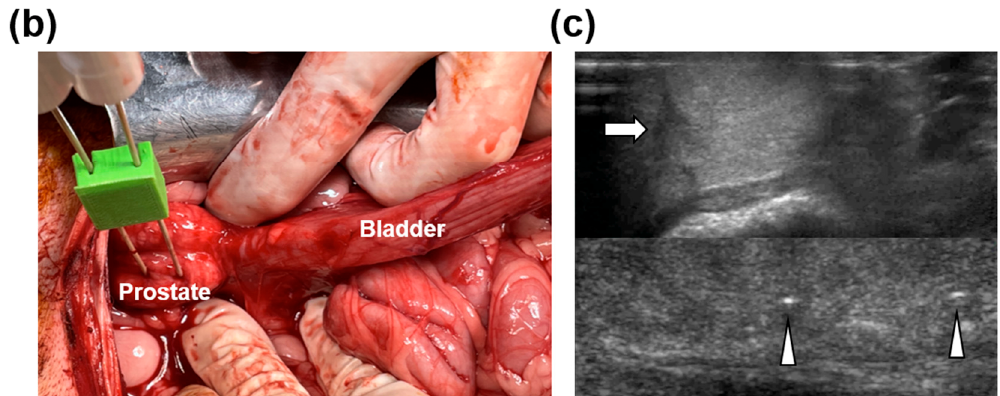
Figure 1. Monopolar electrodes and procedural steps of irreversible electroporation with high-frequency pulsed electric field in the beagle prostate. ( a ) Photograph showing stainless steel monopolar electrodes with 15 mm exposed and 10 mm between the electrodes. ( b ) Photograph obtained during the procedure showing the bladder, prostate, and inserted monopolar electrodes into the left prostate. ( c ) Sonographic images showing the identified prostate tissue (arrow) and the two monopolar electrodes (arrowheads).